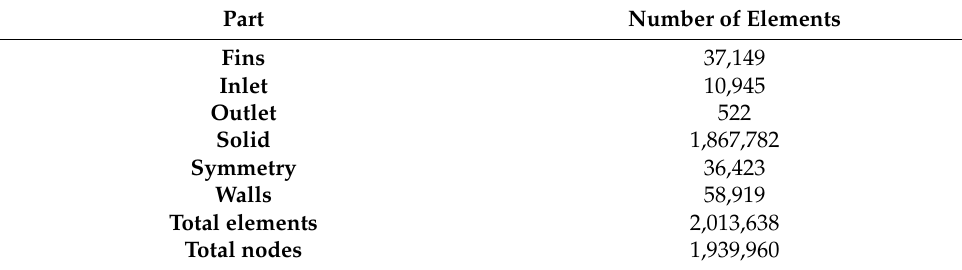
Table 4. Number of elements for generated mesh.